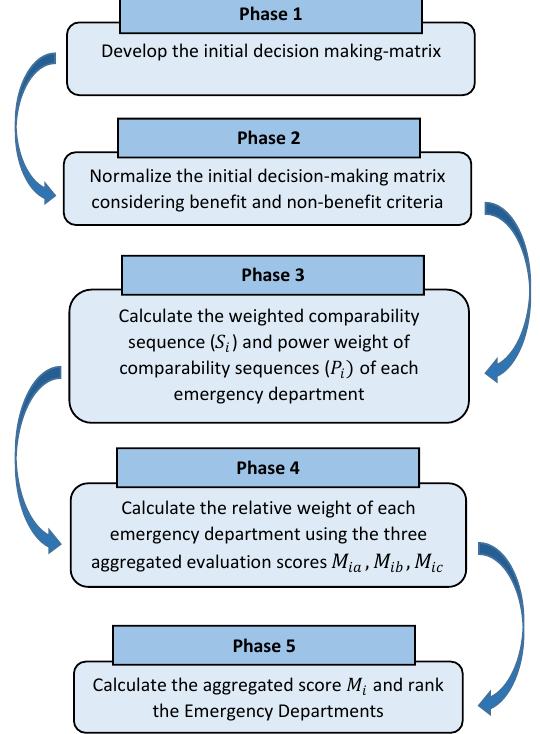
Figure 2. The step-by-step procedure of the CoCoSo method.